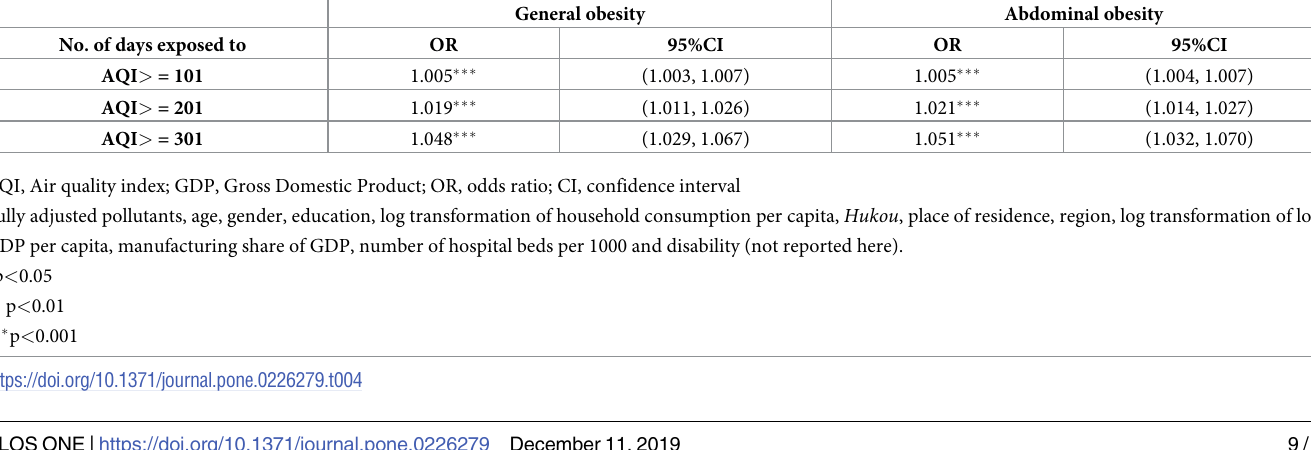
Table 4. Regression results (odds ratio and 95%CI) for associations between chronic exposures to severity of air pollution among older people from the China Health and Retirement Longitudinal Study 2015. General obesity Abdominal